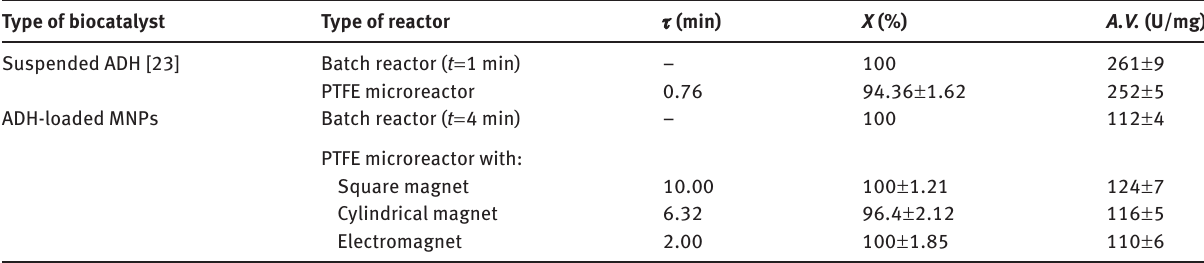
Table 1 Comparison of NAD + coenzyme regeneration within a microreactor and a batch reactor using suspended and immobilsed enzyme. Type of biocatalyst Type of